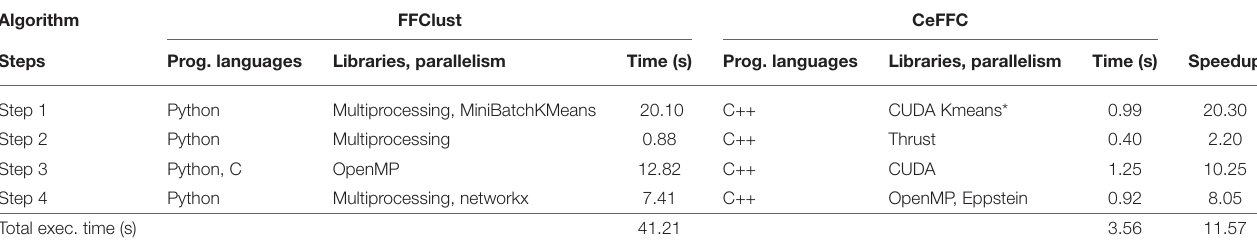
TABLE 1 | Comparison summary by steps between FFClust and our best parallel implementation CeFFC using a tractography of a million fibers.